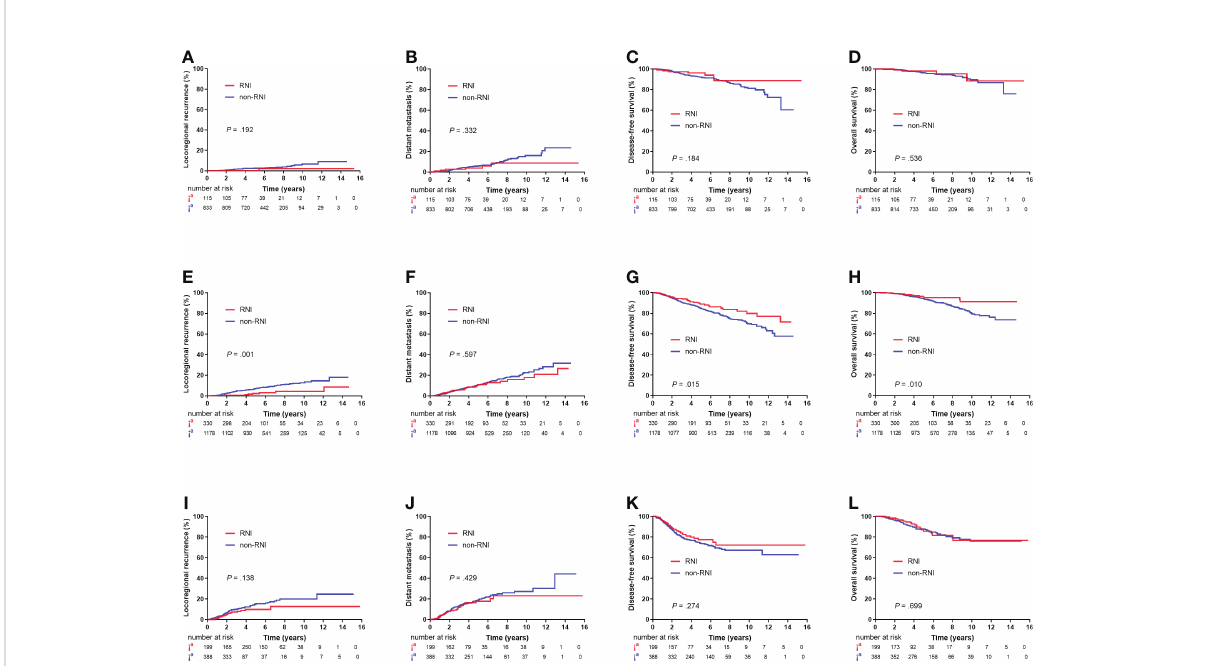
FIGURE 4 Kaplan – Meier plots showing locoregional recurrence, distant metastasis, disease-free survival, and overall survival between the RNI and non-RNI groups in low-risk patients (A – D) , intermediate-risk patients (E – H) , and high-risk patients (I – L)